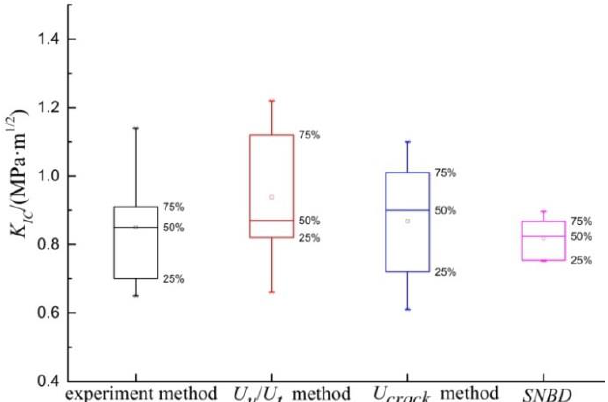
Figure 15. Comparative analysis of shale fracture toughness.